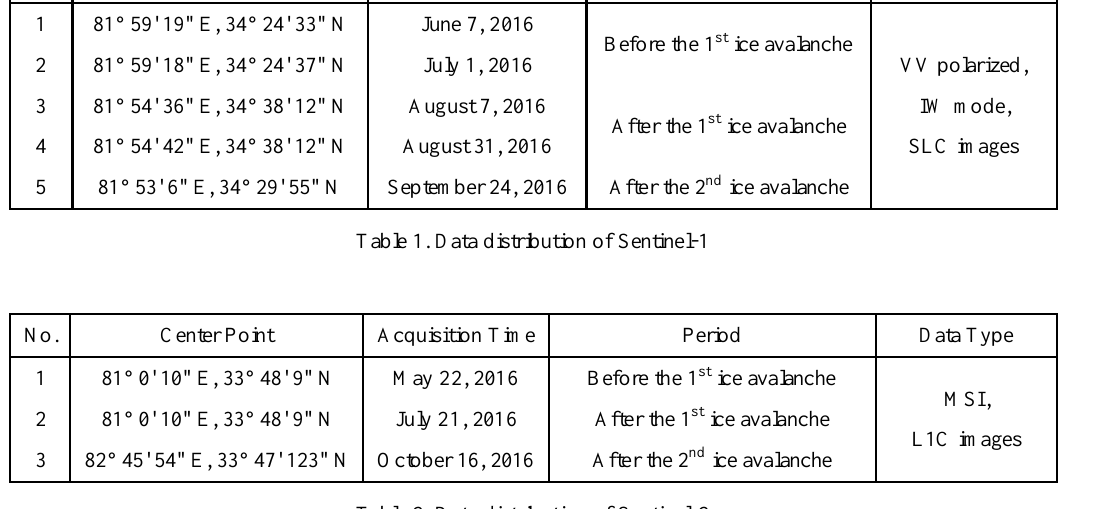
Table 2. Data distribution of